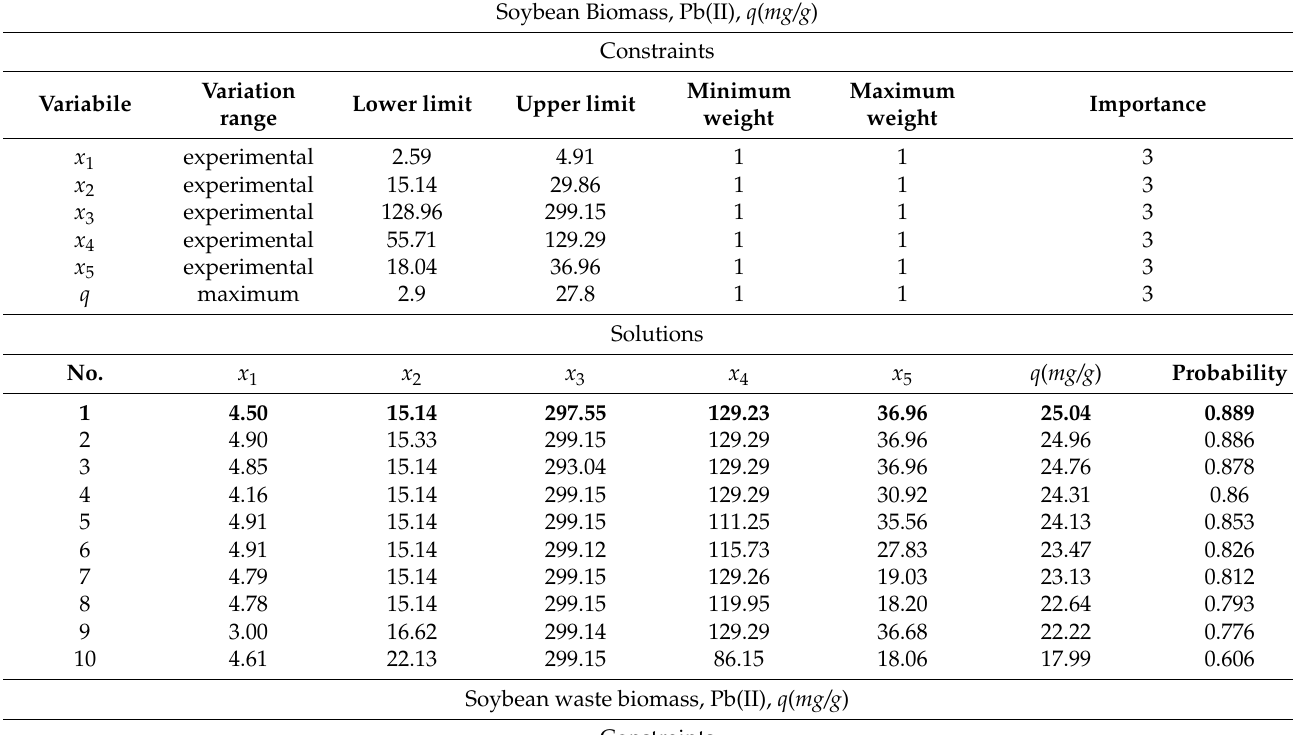
Table 11. Solutions for the operation in favorable conditions for reaching the maximum value of the biosorption capacity ( q , mg/g ) on soybean biomass and soybean waste biomass. Soybean Biomass, Pb(II), q ( mg/g